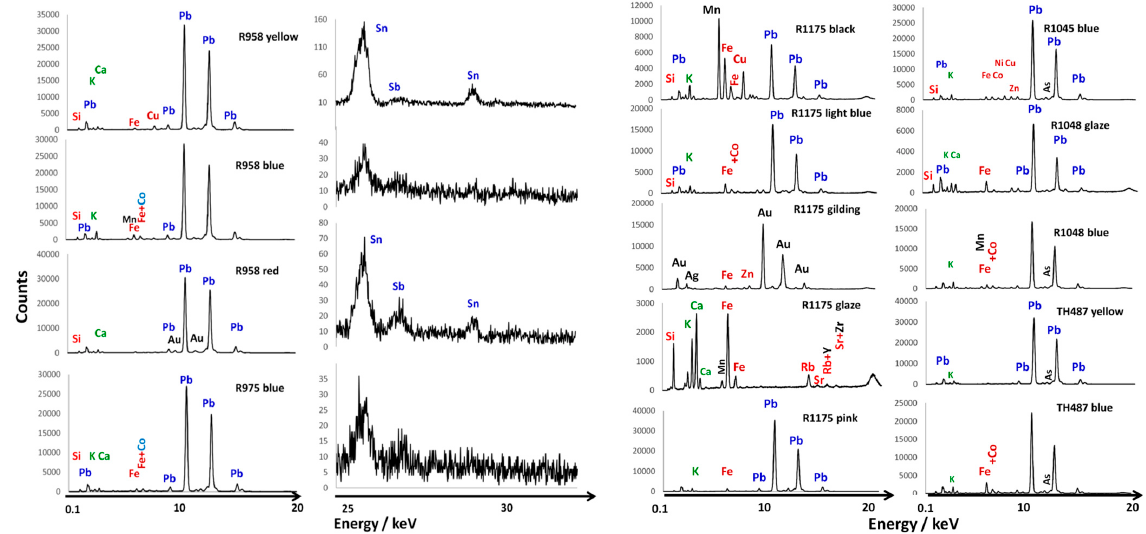
Figure 4. Representative XRF spectra of enameled porcelain and metalware (see Table 1 for de-